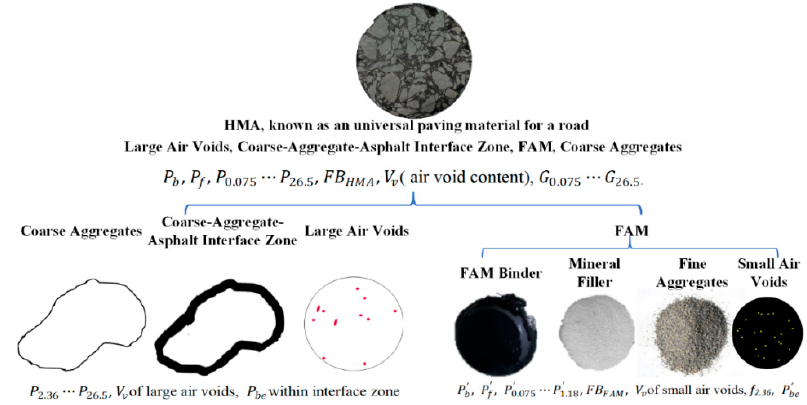
Figure 2. Schematic image to calculate asphalt – aggregate ratio in FAM.